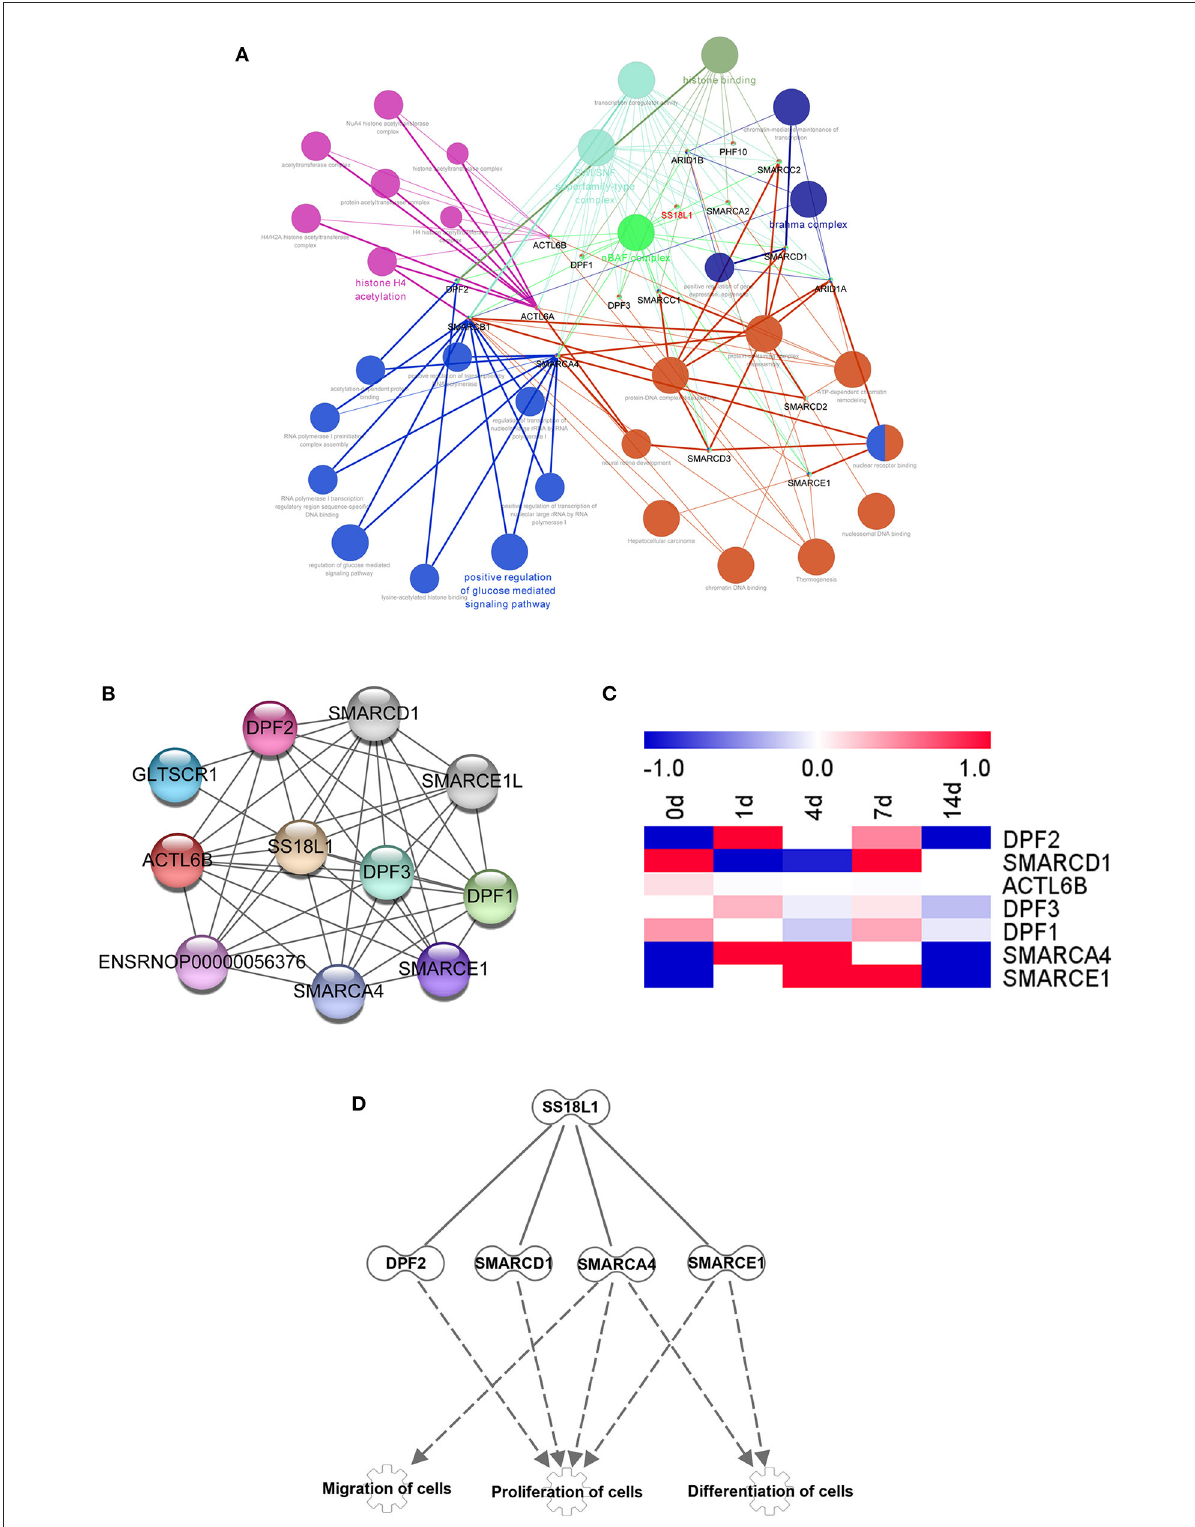
FIGURE7 Bioinformatics analysis showing SS18L1-centered genetic network. (A) Cytoscape software predicted the associated genes and biological functions of SS18L1. Different colors of network nodes, respectively, represent various biological functions, while node sizes reflect